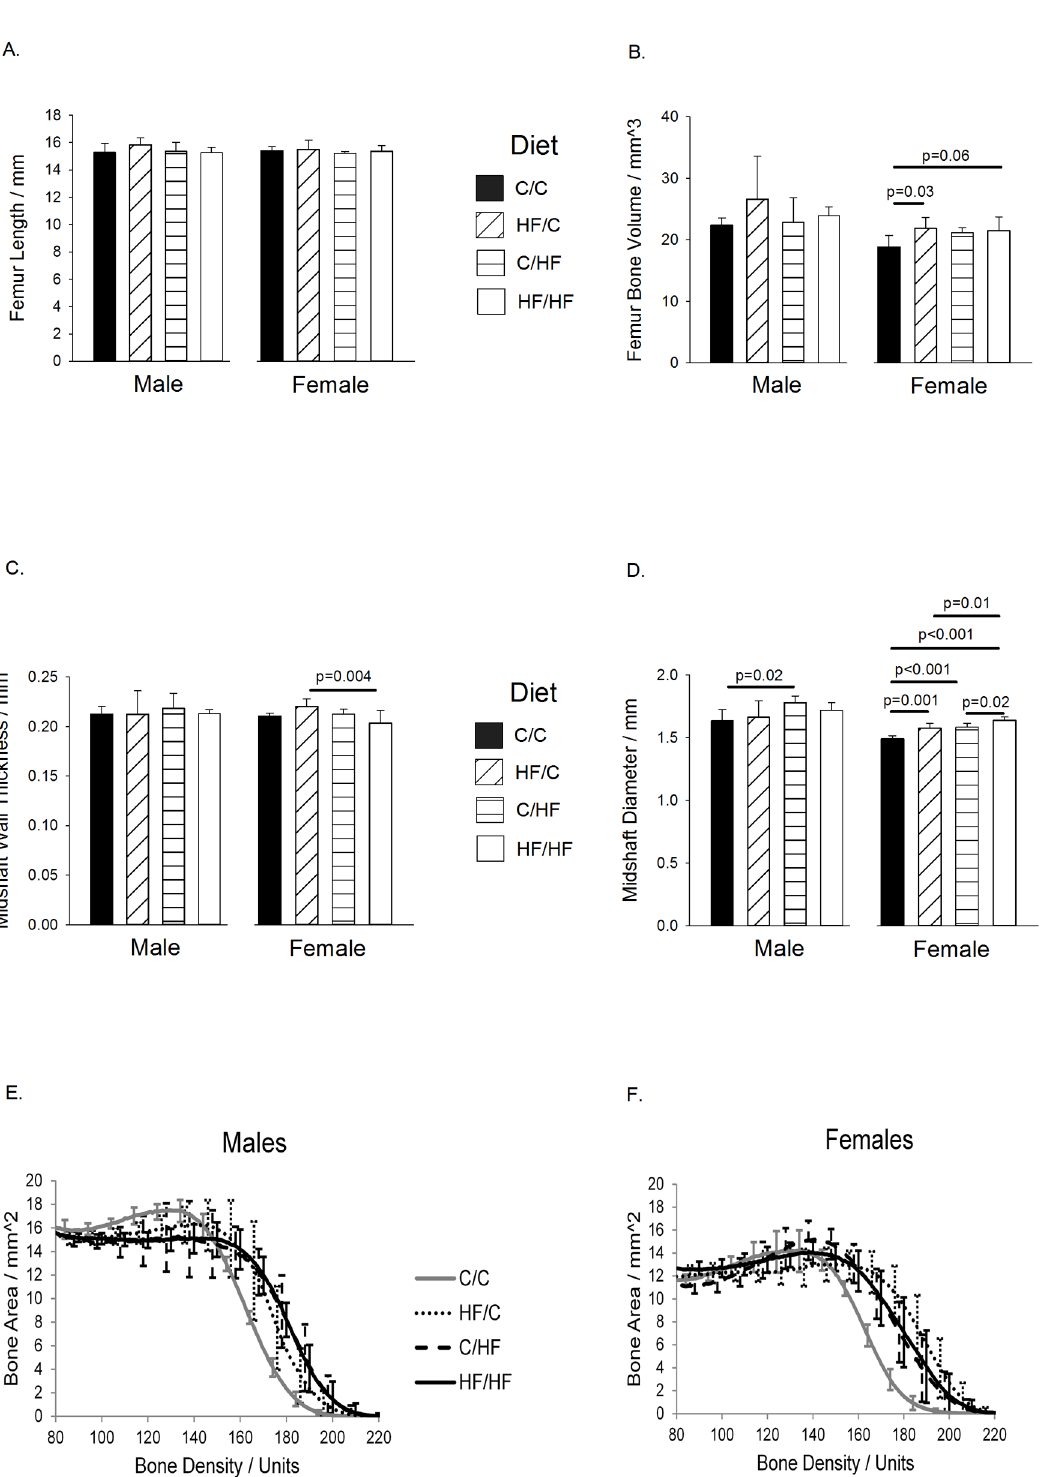
Fig 2. Femoral Bone Structure at Thirty Weeks of Age. For dietary group and sex, results are shown for (A). Femur length. (B). Femur bone volume. (C). Midshaft wall thickness. (D). Midshaft diameter. (E). Male femur bone density. (F). Female femur bone density. For density graphs, the bone density range 80 – 140 represents trabecular bone, and 140 – 220 represents cortical bone. For all groups, n = 5 – 7 per group. Graphs show mean plus 95% confidence limits.